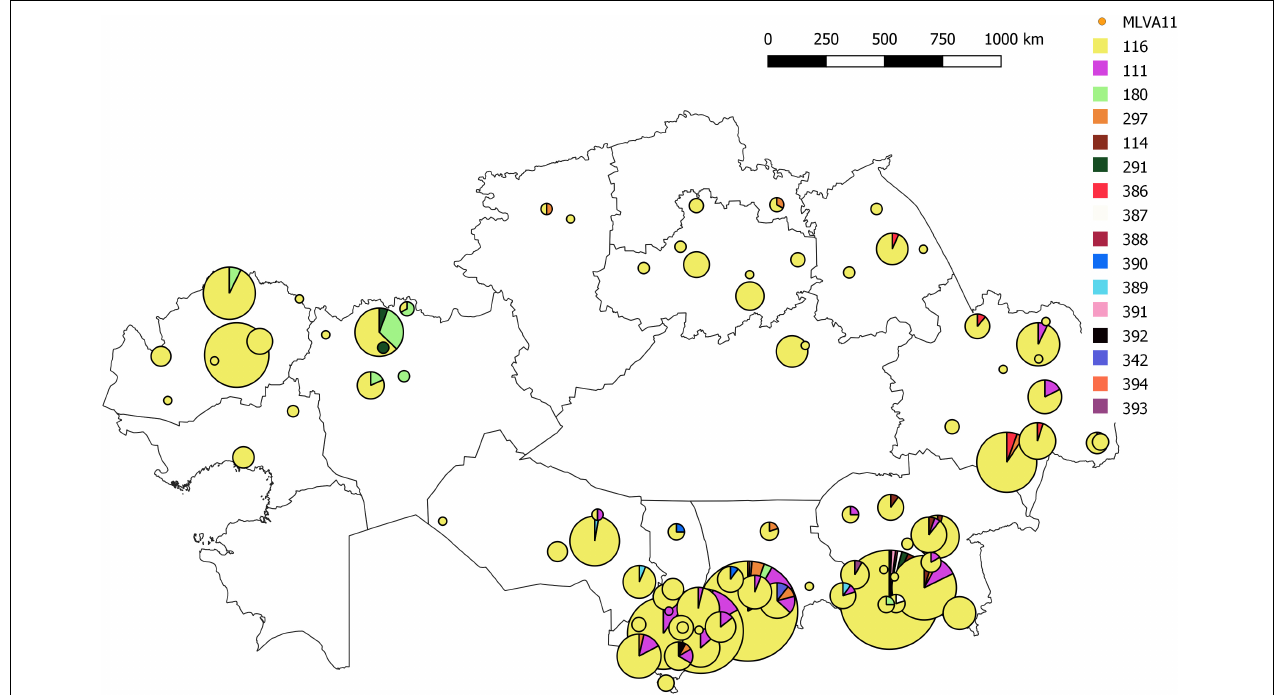
FIGURE 2 | Map of Kazakhstan showing the distribution of B. melitensis MLVA11 genotypes of the 1327 strains from human patients. The color code reflects the MLVA11 genotype. The number of strains assigned to a given genotype is indicated in detail in Supplementary Table S2 .